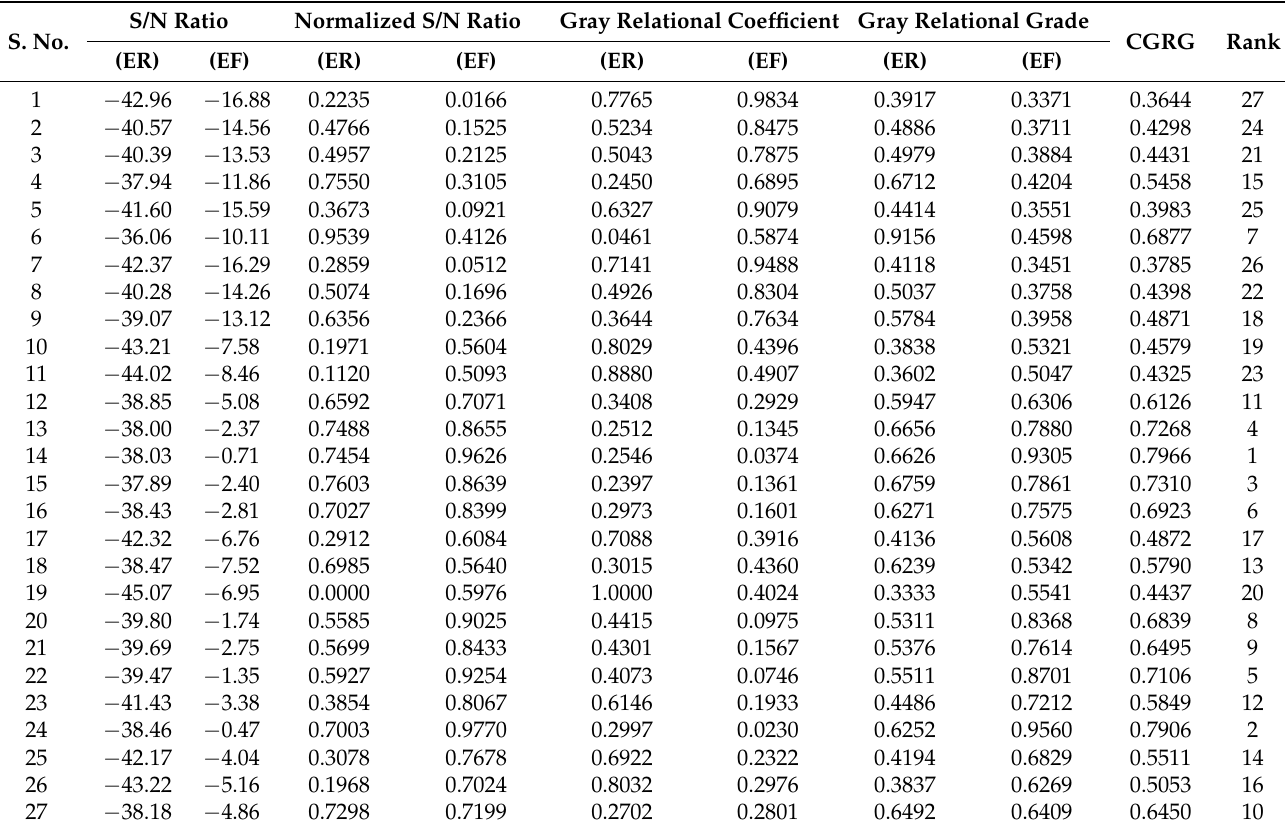
Table 3. Gray relation coefficient with grade and their